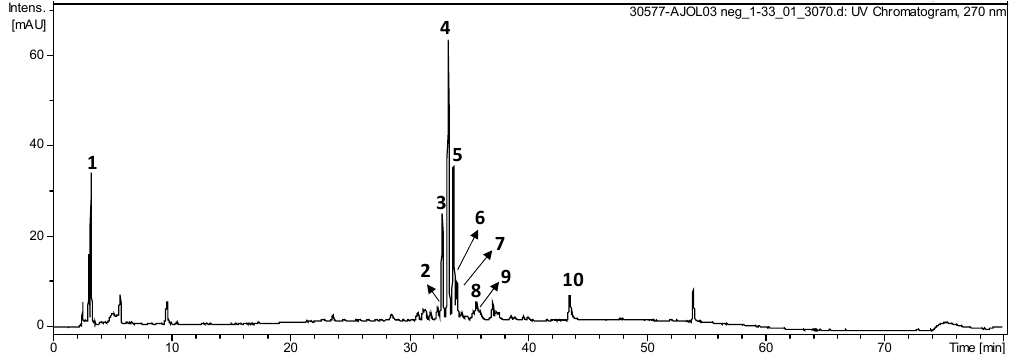
Figure 6. HPLC chromatograms of phenolic compounds detected at 270 nm in the hydroethanolic pollen extract collected by S. aff. postica. Antioxidants 2020 , 9 , x FOR PEER REVIEW Table 3. Compounds identified by LC-ESI-IT-MS/MS on negative mode, in pollen extract collected by S. aff. postica.